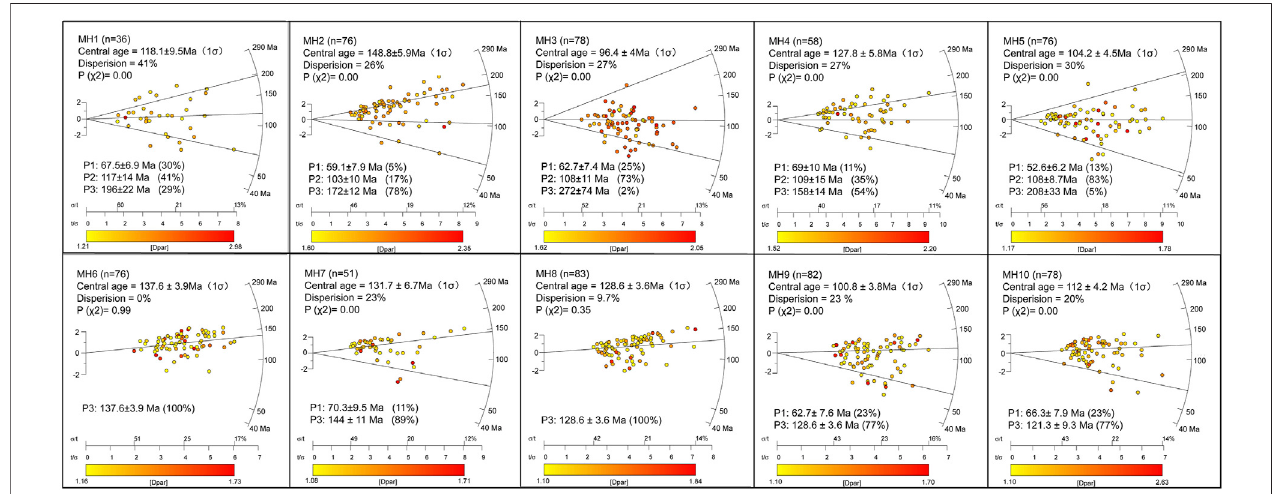
FIGURE 4 | Fitting age peaks by Density Plotter.